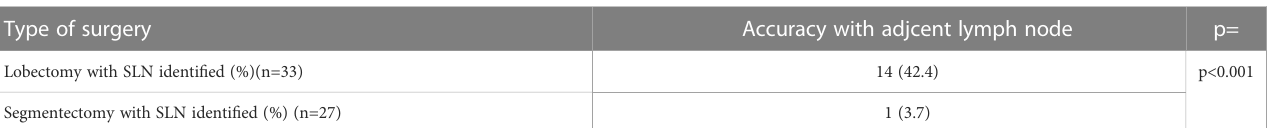
TABLE 3 Accuracy of lymph node analysis. Type of surgery